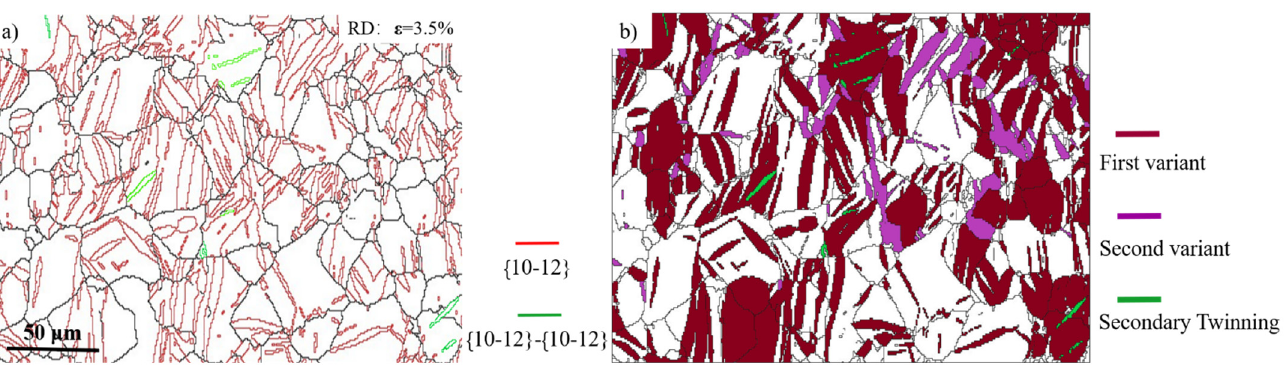
a similar crystal orientation and all twins were close to the TD direction, which is different from the direction of the applied stress, indicating that both non-Schmid primary twin variants and secondary extension twins were caused by other parameters.